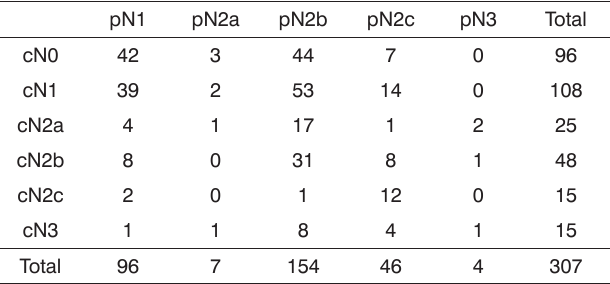
Tabela 2. Distribuição dos pacientes em função dos estádios clínico e patológico do pescoço.